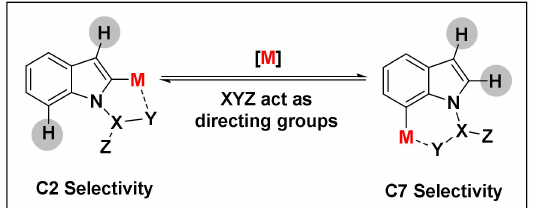
Scheme 24. C2 vs. C7 position using directing group at N1